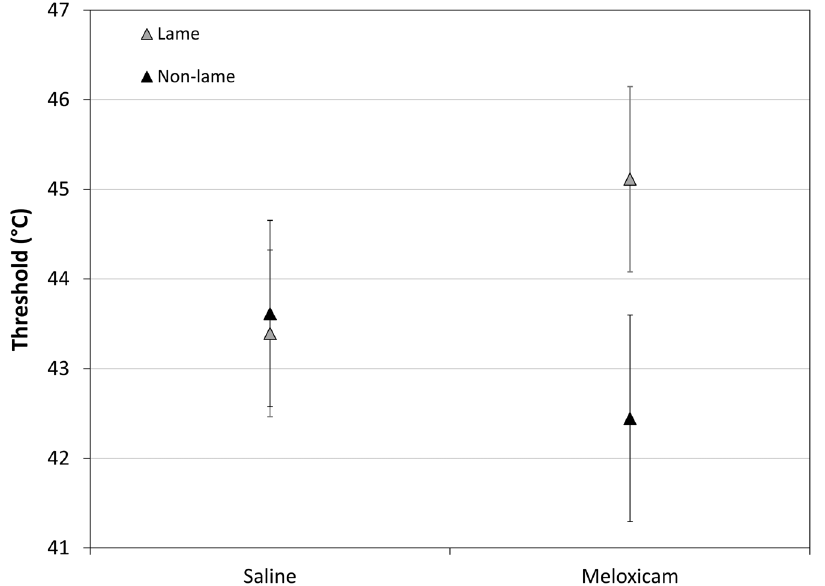
Figure 3. Effects of meloxicam on threshold. Modelled predictions (means 6 95% confidence intervals) of thermal nociceptive threshold for lame and non-lame birds administered saline or meloxicam (keeping all other variables in the model at reference values.